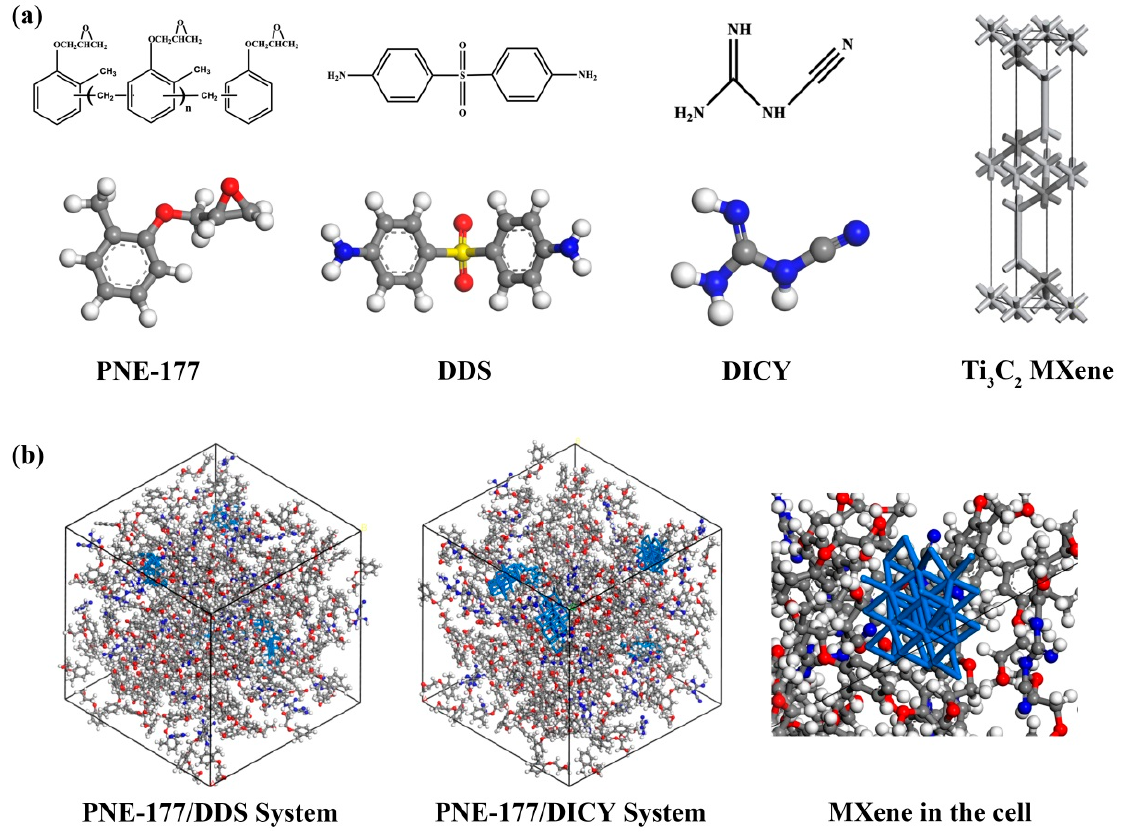
Figure 2. The molecular structure ( a ) and epoxy resin system ( b ) using MD simulations.